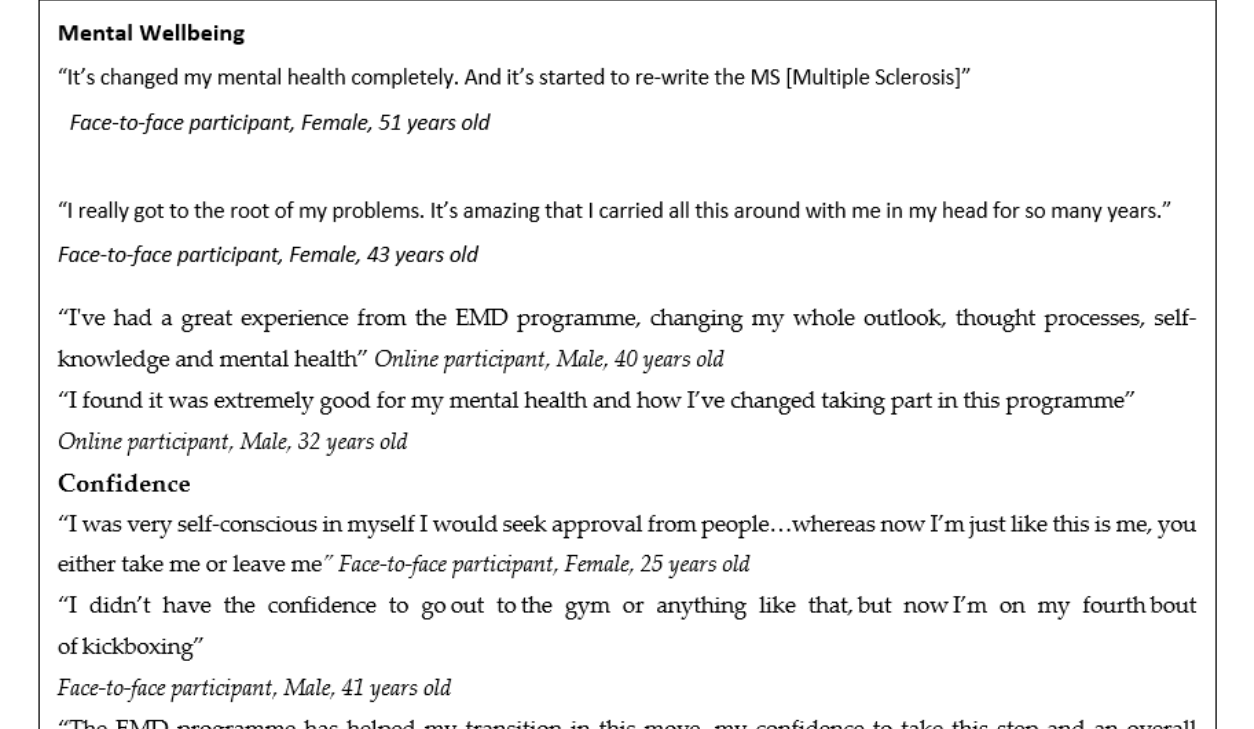
Figure 4. Selected quotes from face-to-face and online participants.